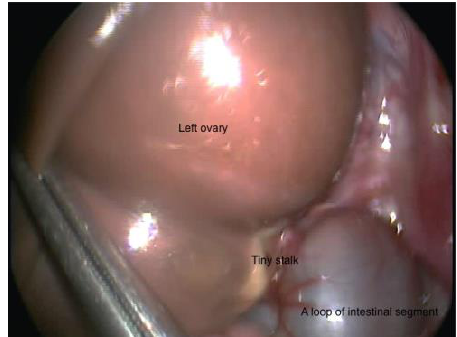
Figure 1: A loop of intestinal segment twisted around the calcified stalk of the left brownish ovarian cyst.